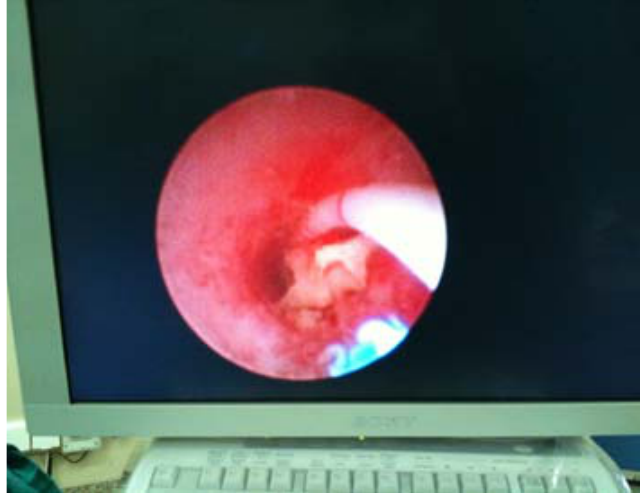
FIGURE 1 - A F 4 ureteral catheter was inserted through stones to continuously perfuse with normal